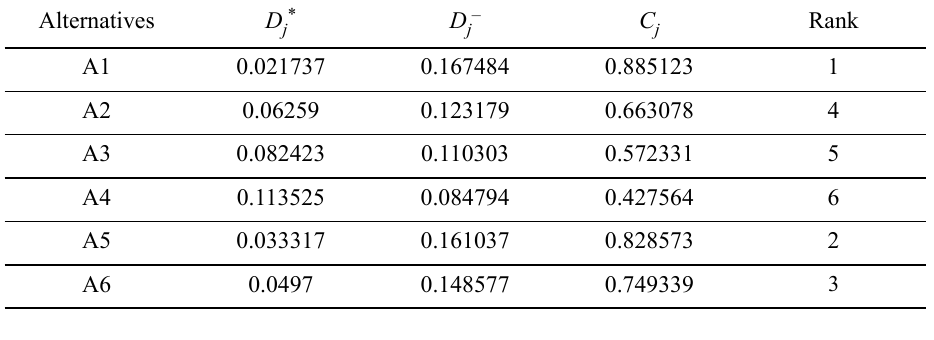
Table 13. Closeness coefficients and ranking of alternatives